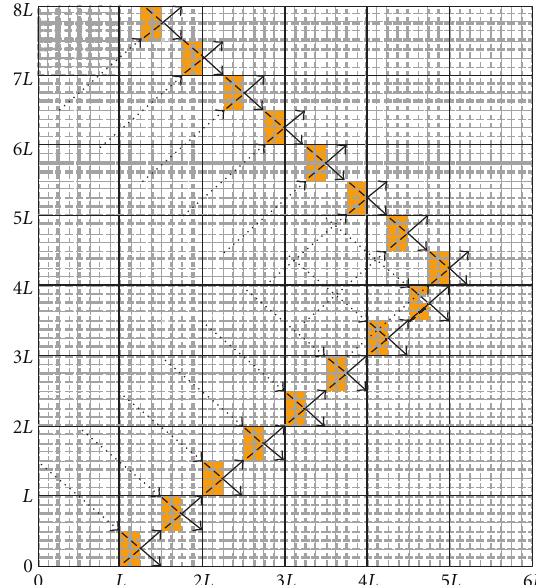
Figure 9: DFG for double-flow structures (DFS, Π = L , π = 1 / 2, shift = L/